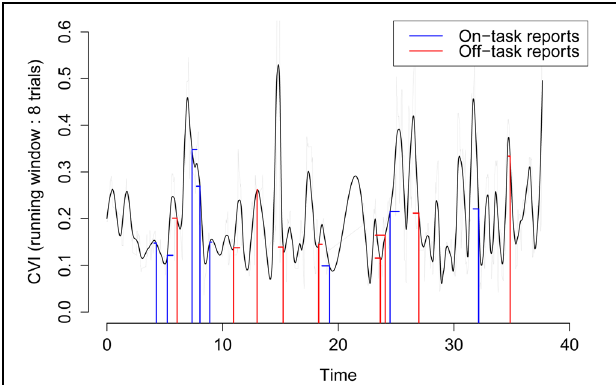
FIGURE 2 | Distribution of the Continuous Variability Index (CVI) across the experimental session of an arbitrary participant (time in minutes). Vertical lines represent the CVI value (in RTCV units) at the moment of the report, horizontal lines represent temporal distance from the report to the closest peak in the CVI. We predict that On-task reports (blue) have a lower CVI (shorter vertical lines), and a higher temporal distance to their closest peak (longer horizontal lines) than Off-task reports